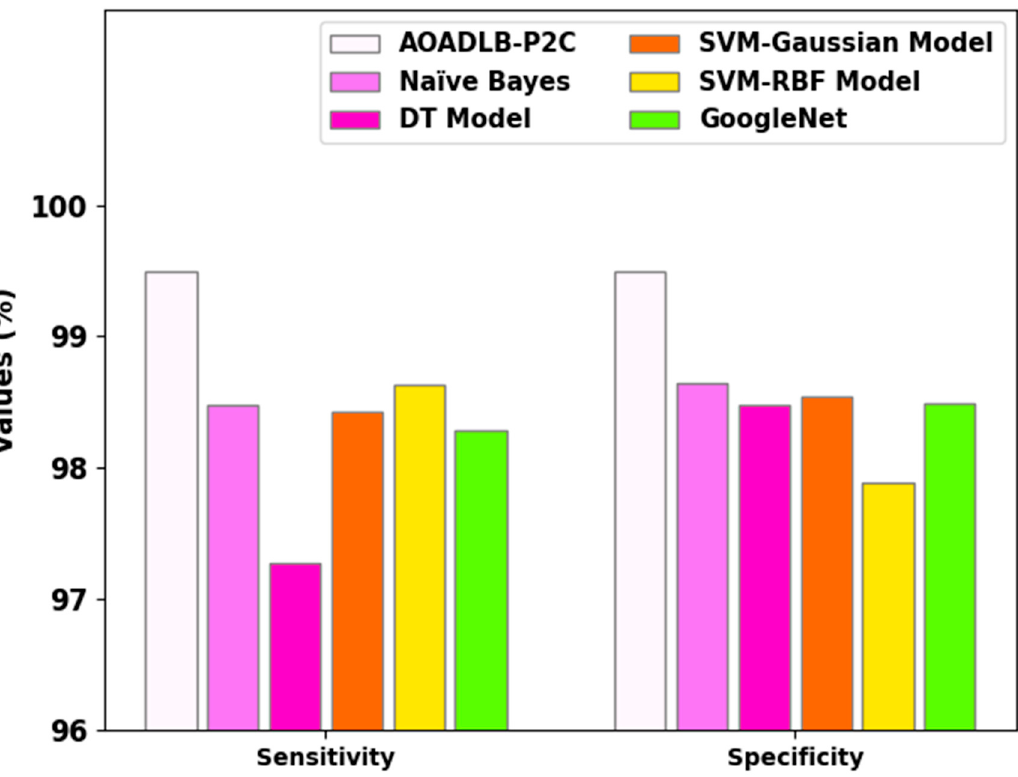
Figure 9. 𝑆𝑒𝑛𝑠 (cid:3052) and 𝑆𝑝𝑒𝑐 (cid:3052) analytical results of the proposed AOADLB-P2C system and other Figure 9. Sens y and Spec y analytical results of the proposed AOADLB-P2C system and other re- recent approaches. cent